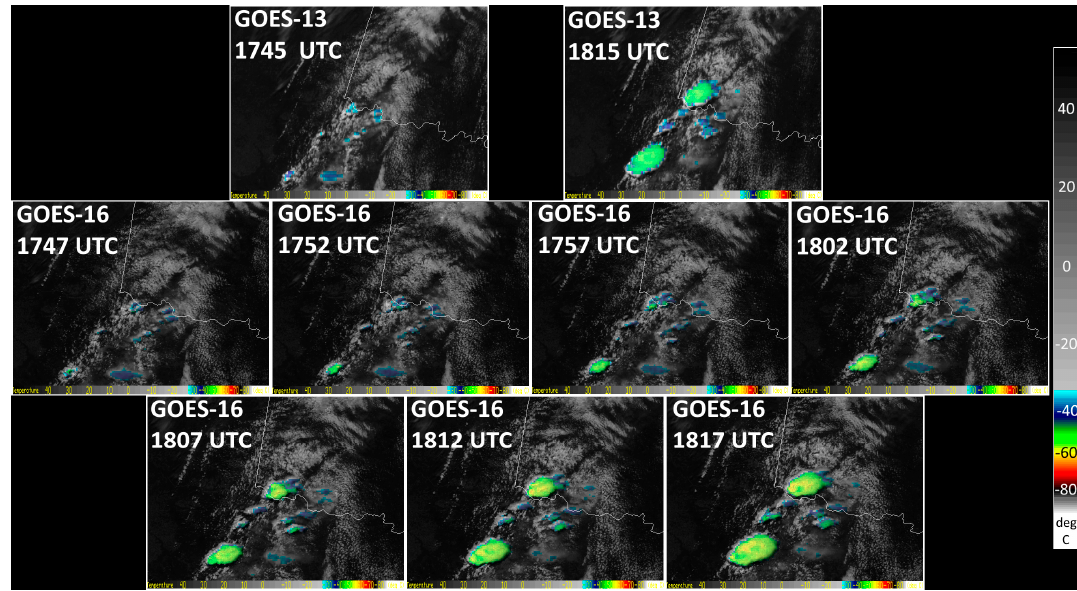
Figure 20. Top panels show images collected by GOES-13 Imager, and the middle and bottom panels show images collected by ABI on GOES-16. The geographic area covering parts of Texas and Oklahoma were extracted from the GOES-13 full disk imagery that is collected every 30 min. ABI collected data every 5 min over the same region. Both GOES-13 and GOES-16 images shown here are created using similar visible (band 1 from Imager and band 2 from ABI) and IR bands (band 4 from Imager and band 13 for ABI) [23]. The IR data have been color enhanced based on brightness temperature (in °C) and made partially transparent so that information from the visible can also be seen.